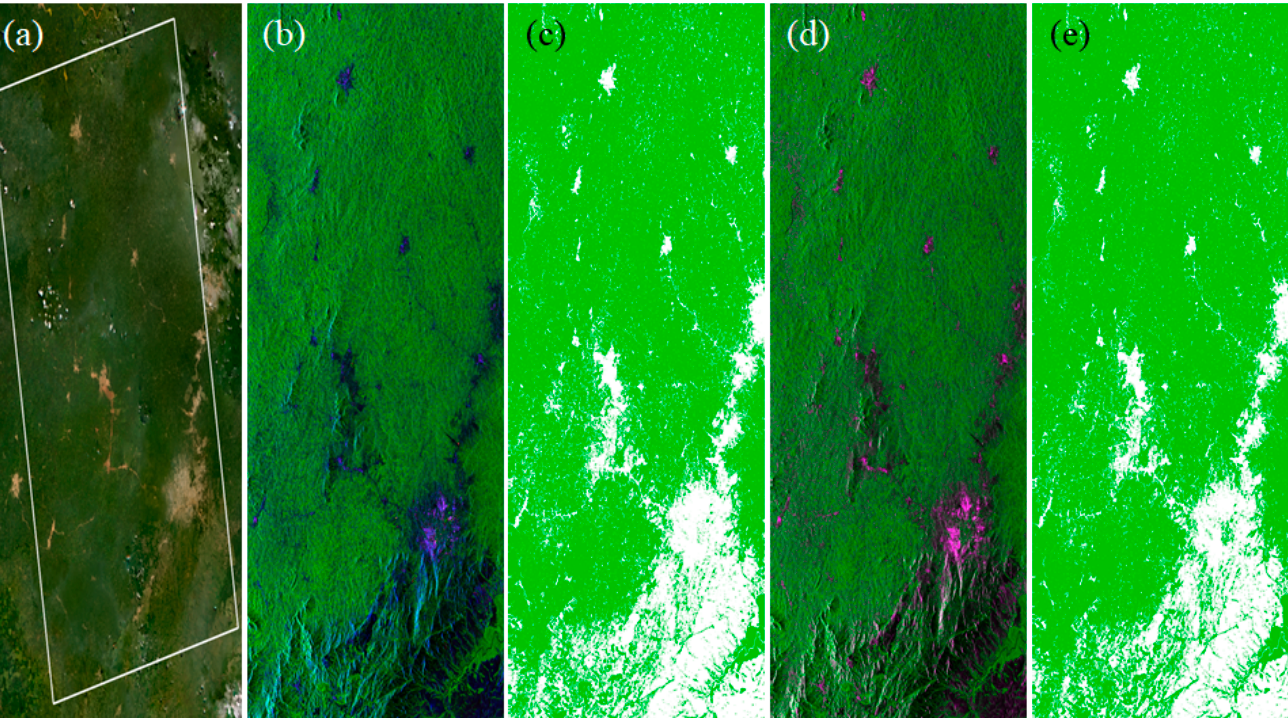
Figure 5. Forest maps of the Congo Basin in the Republic of the Congo using the proposed method and 6SD method with the POLSAR data acquired on 7 May 2016 and a window size of 10 × 20 pixels. ( a ) Mosaic image acquired by Planet/Dove from December 2015 to May 2016. The white rectangle shows the observation area of PALSAR-2. ( b – e ) Same as in Figure 3.